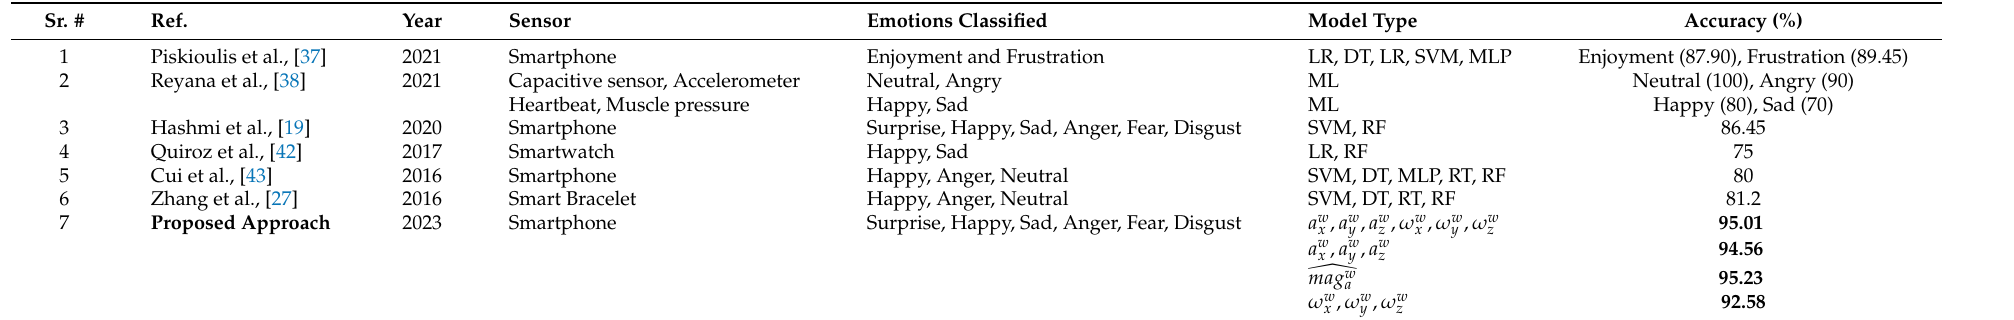
Table 6. Performance comparison of the proposed work with previous